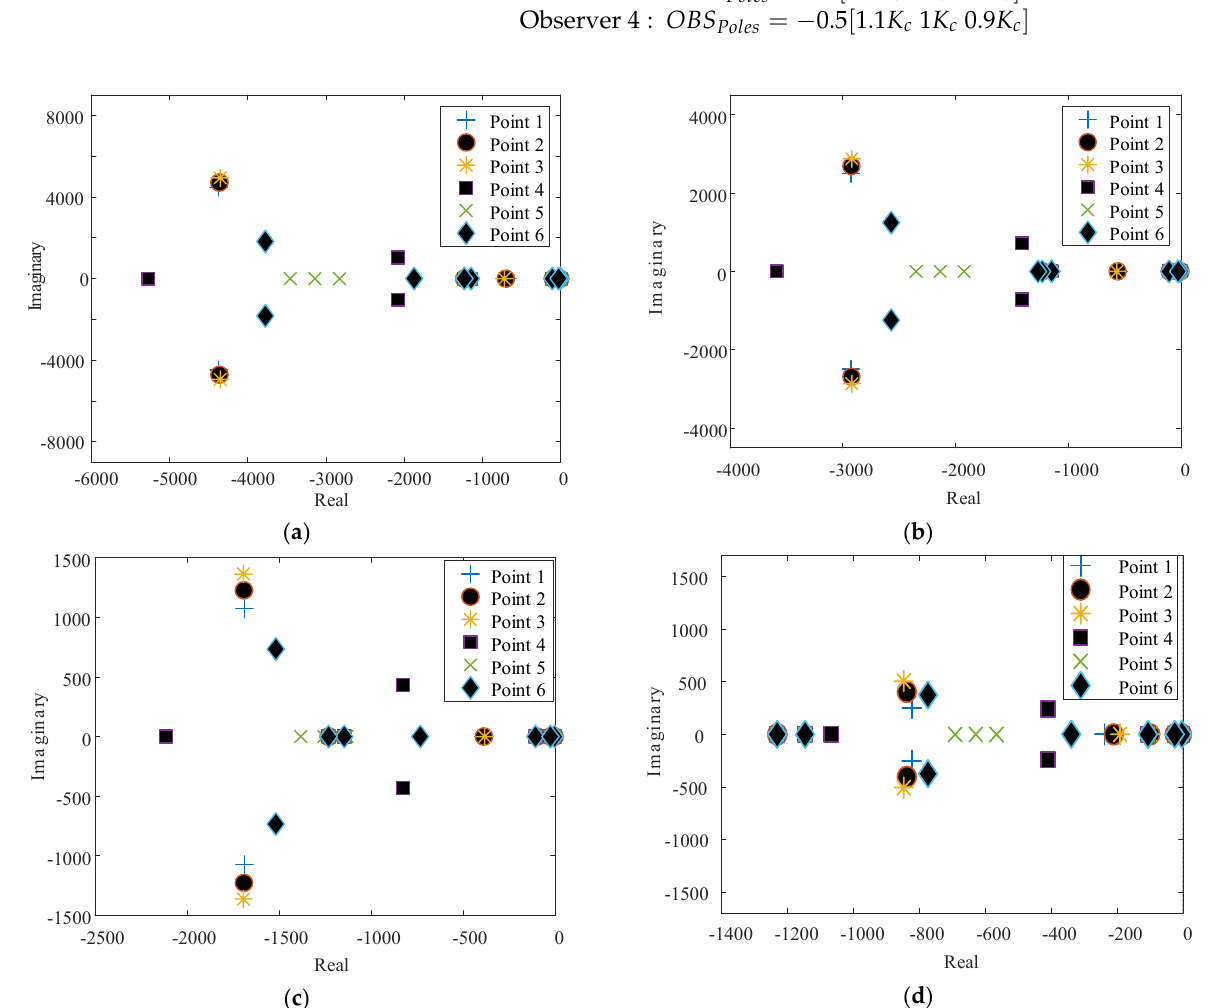
Figure 5. The change of the overall system poles for 4 different observers in 6 different